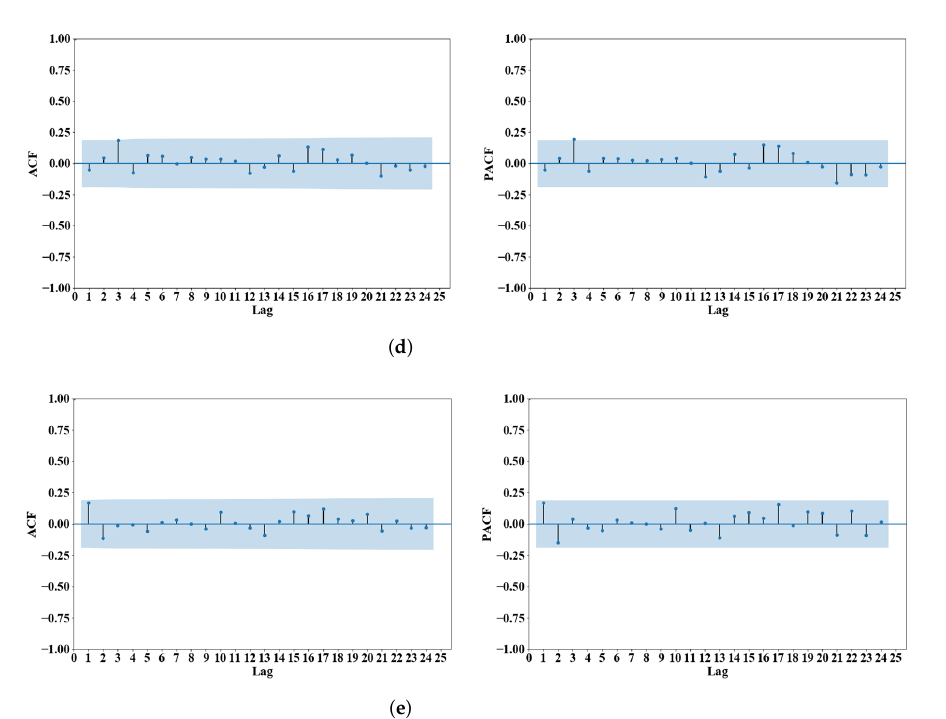
Figure 4. Estimated residual ACF and PACF using different ARIMA models. ( a ) ARIMA(0,0,1) × (0,1,2) 12 . ( b ) ARIMA(1,0,1) × (0,1,2) 12 . ( c ) ARIMA(0,0,0) × (0,1,2) 12 . ( d ) ARIMA(1,0,0) × (0,1,2) 12 . ( e ) ARIMA(1,0,2) × (0,1,2) 12